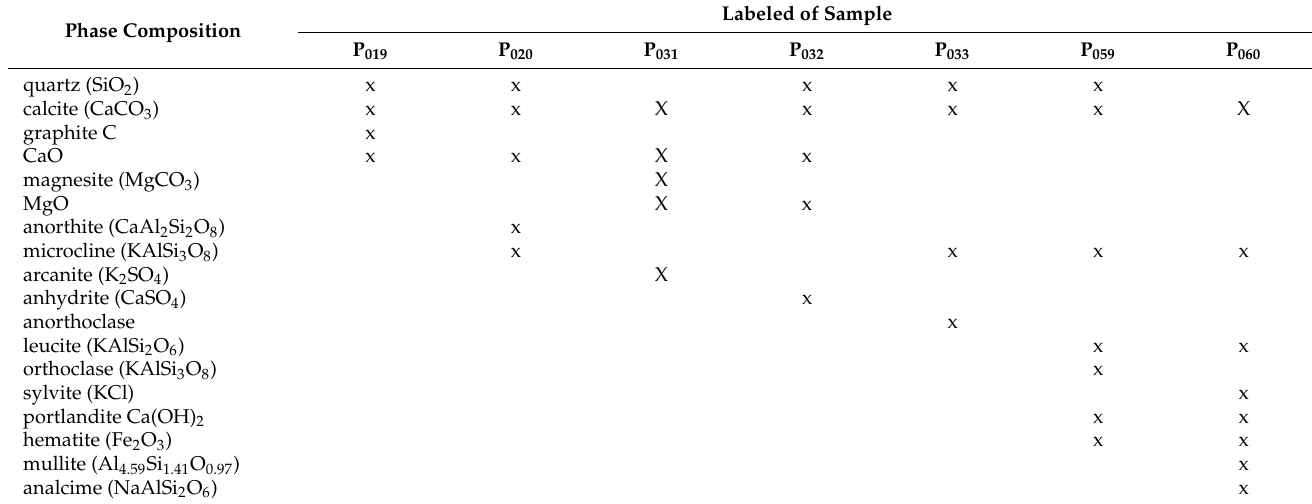
Table 5. Phase composition of analyzed biomass ash samples.